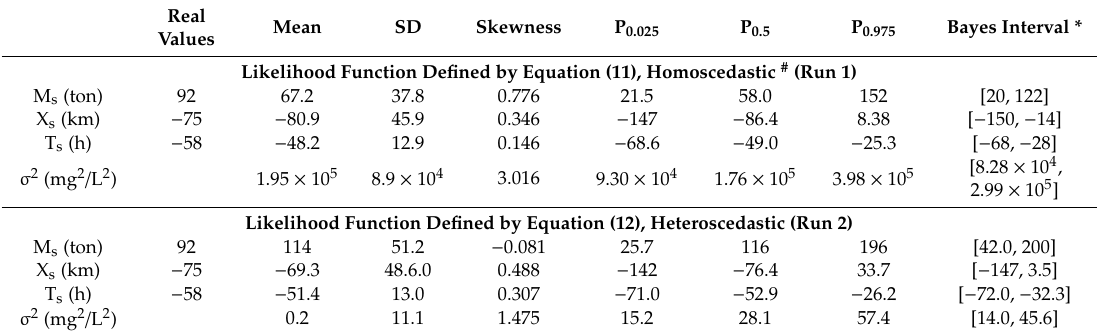
Table 3. Summary statistics of the inverse results at the Songhua River.